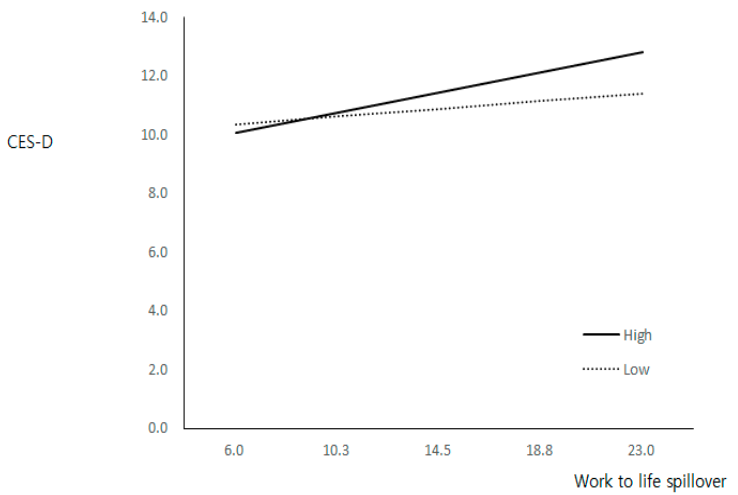
Figure 2. Interaction effects of social activities satisfaction on the relationship between work-to-life negative spillover and